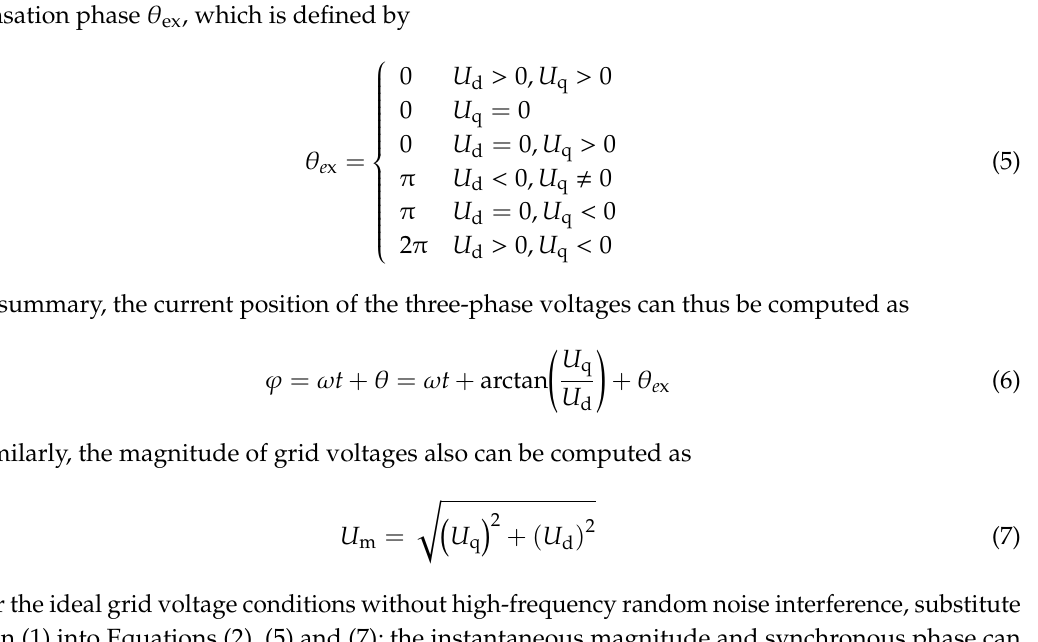
Figure 2. Initial phase waveform under high-frequency random noise conditions.